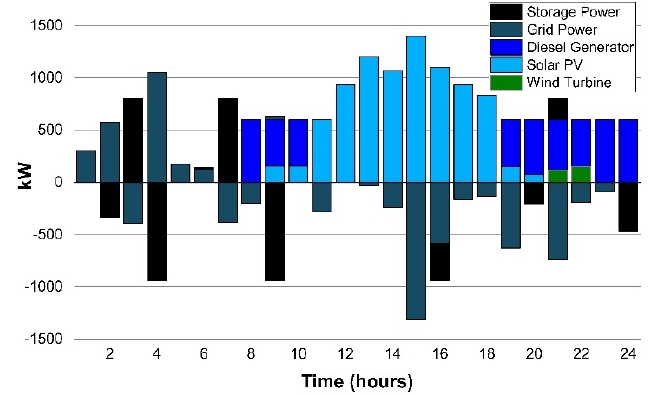
Figure 9. Scenario 1(e): Energy exchange with the grid.